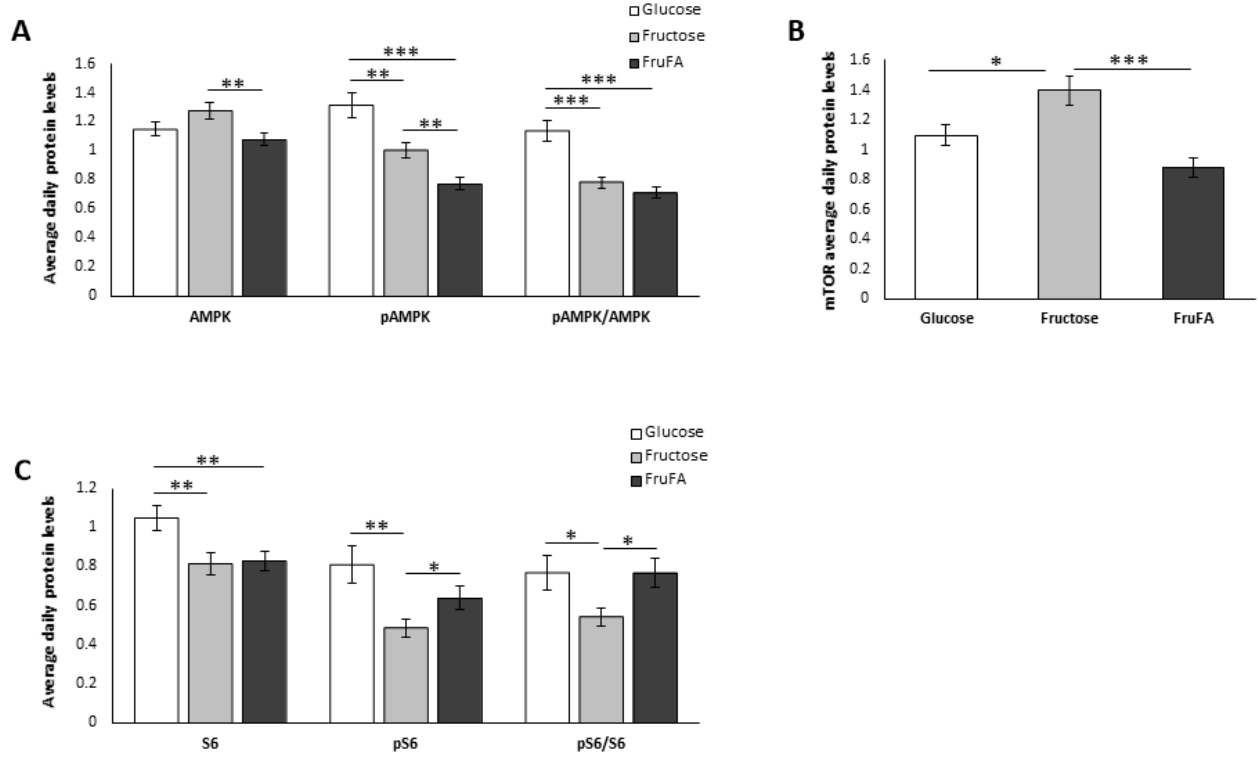
Figure 2. Effect of fructose and fructose-induced steatosis on metabolism in AML-12 hepatocytes. ( A ) Daily average protein levels of AMP-activated protein kinase (AMPK), its phosphorylated form (pAMPK), and the pAMPK/AMPK ratio. ( B ) Daily average protein levels of mammalian target of rapamycin (mTOR). ( C ) Daily average protein levels of S6, pS6, and the pS6/S6 ratio. One hundred and fifty thousand cells per mL were used in each treatment. Values are means ± SE. Asterisks denote significant differences by t -test (* p < 0.05; ** p < 0.01; *** p <